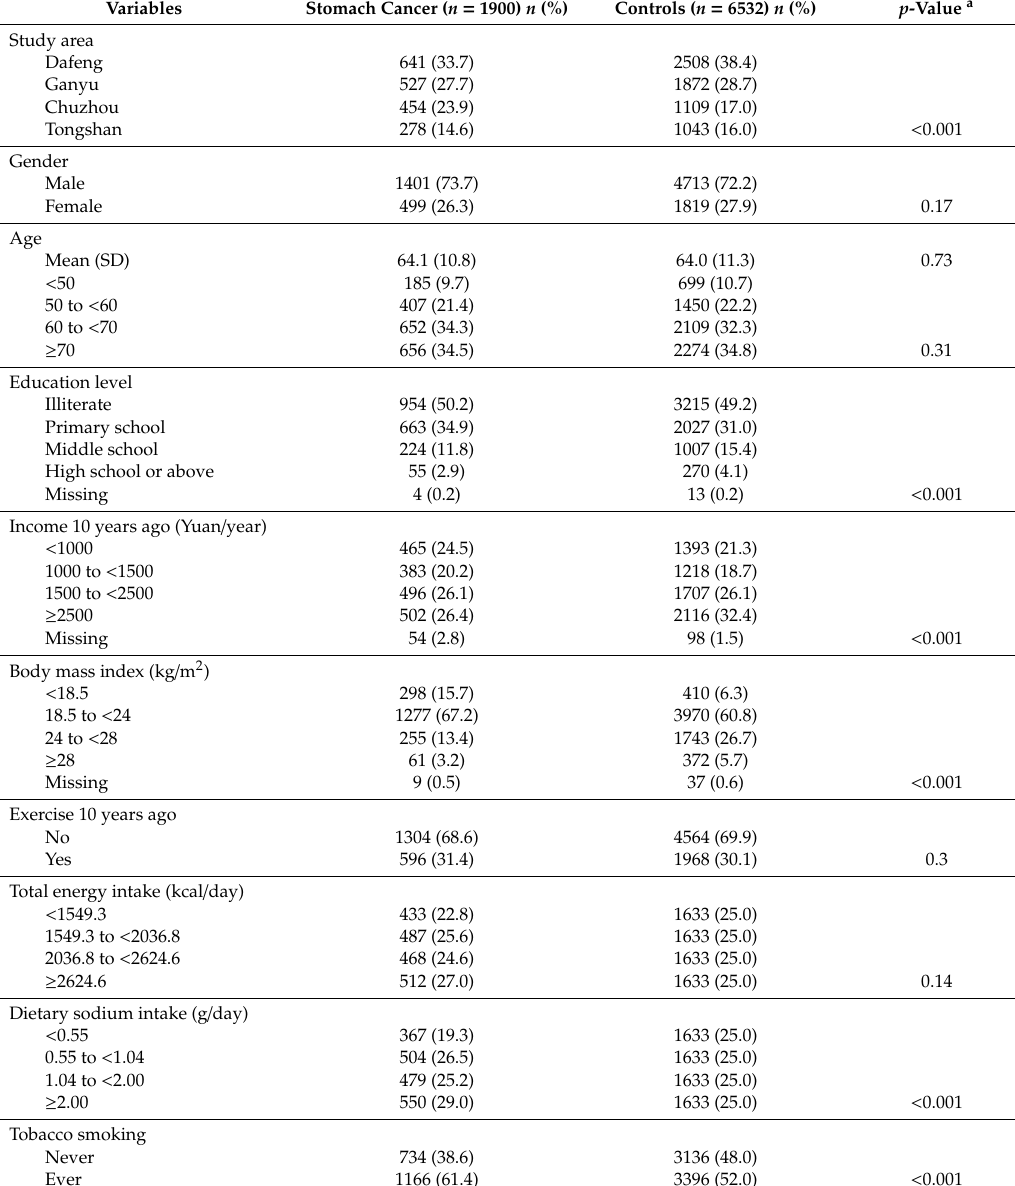
Table 1. Demographic characteristics of stomach cancer and population controls among participants (cases = 1900, controls =